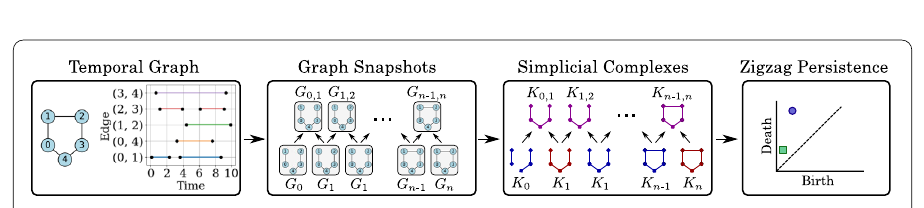
Figure 4 Pipeline for applying zigzag persistence to temporal networks. Begin with an unweighted and undirected temporalgraph where each edge is on at a point or interval of time. Create graphsnapshots using a sliding window interval over the time domain. Create a sequence of simplicialcomplexes from the graphs and apply zigzagpersistence to the union zigzag simplicial